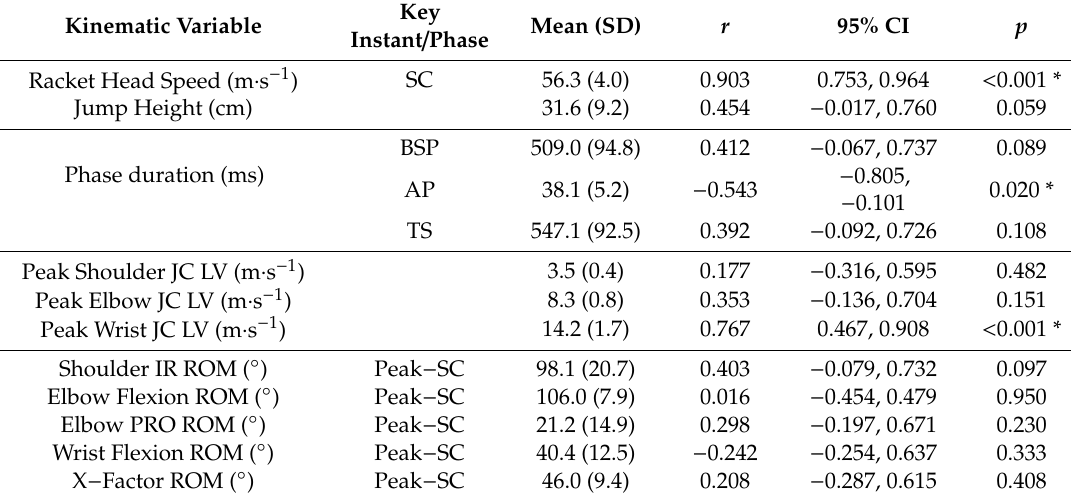
Table 2. Pearson product moment correlation (r) between each of racket head speed, jump height, phase durations, joint centre linear velocities and ranges of motion, and shuttlecock speed. Kinematic Variable